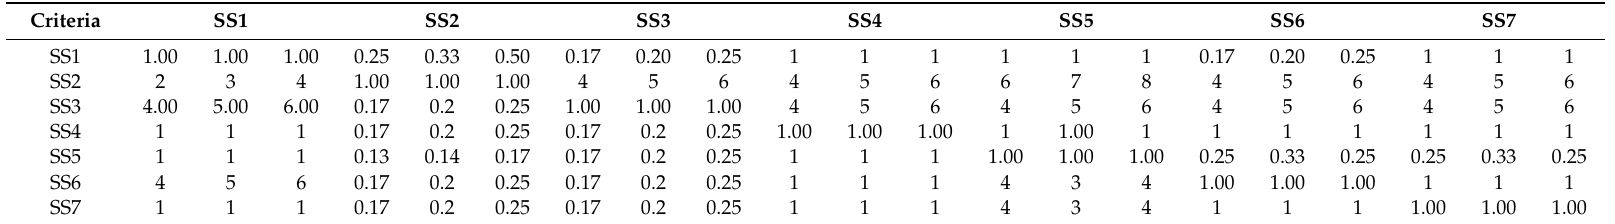
Table 3. Pairwise comparison matrix for Respondent 1.